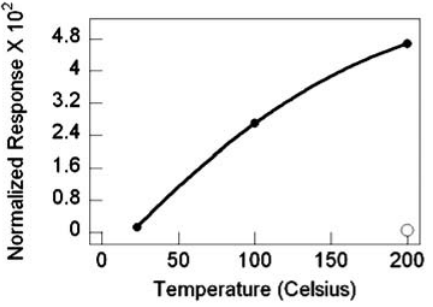
nanowire sensor response versus temperature, filled circles are with Pd Figure 21. SnO 2 catalyst, the nonfilled circle is without catalyst.